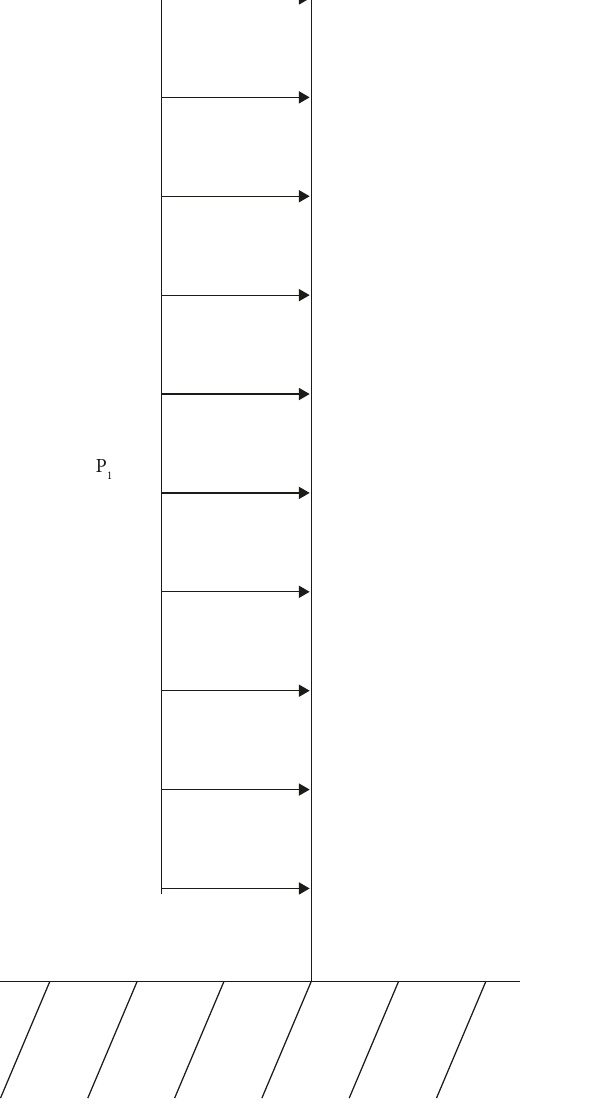
Figure 8: Calculation diagram of the cantilever section of the front